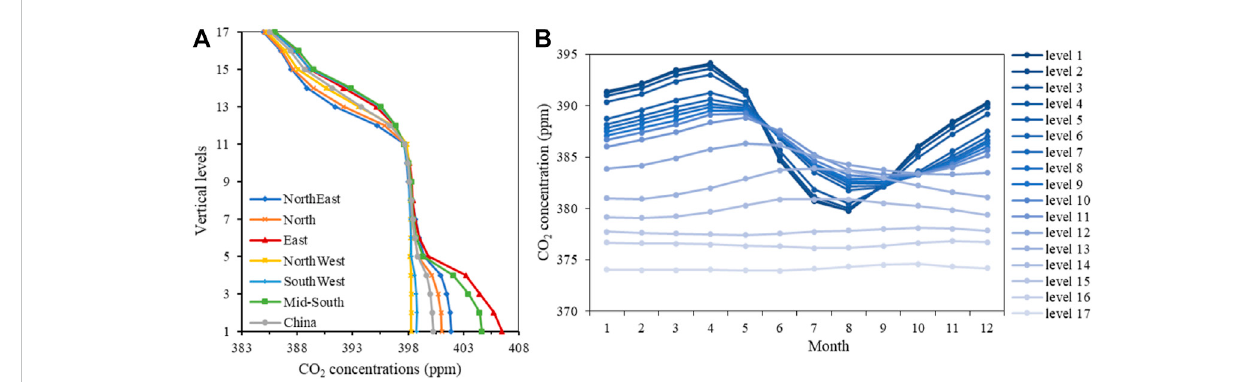
FIGURE 9 Vertical pro fi les (A) and the seasonal variation (B) of atmospheric CO 2 over China.